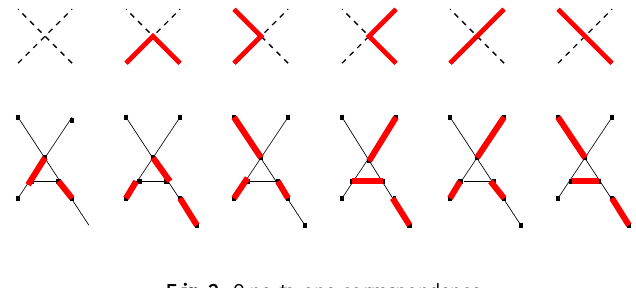
Fig. 2: One-to-one